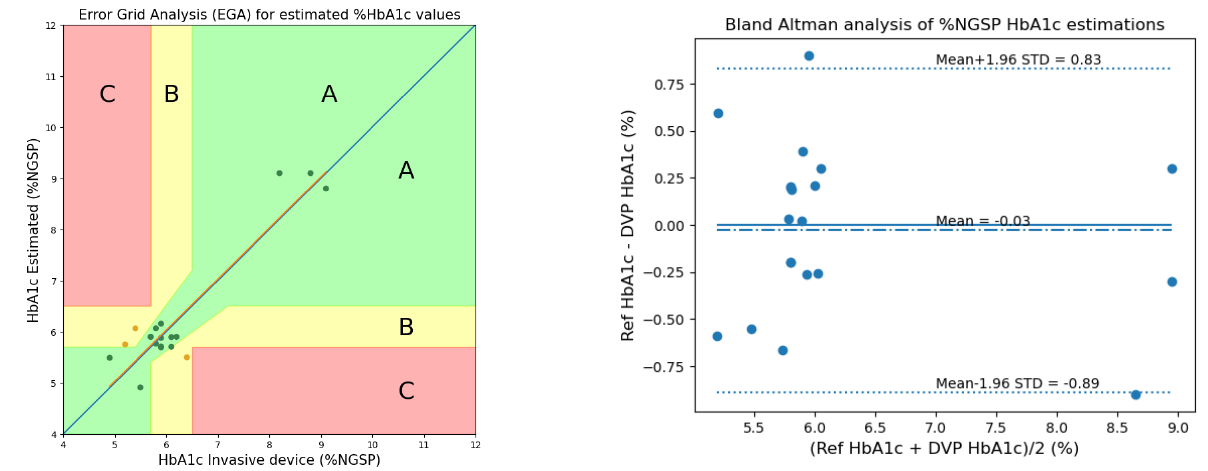
Figure 5. EGA and Bland–Altman analysis for the HbA1c estimation with the blood vessel model (considering both ratio and value calibrations).